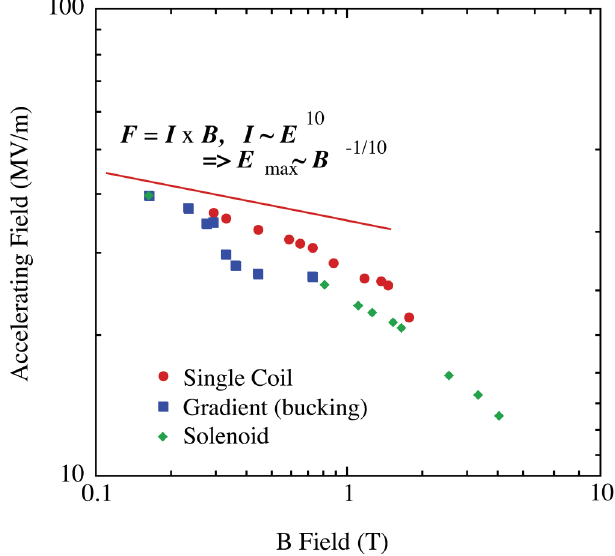
FIG. 2. (Color) Breakdown threshold as a function of static magnetic field at the cavity surfaces for different magnetic configurations.